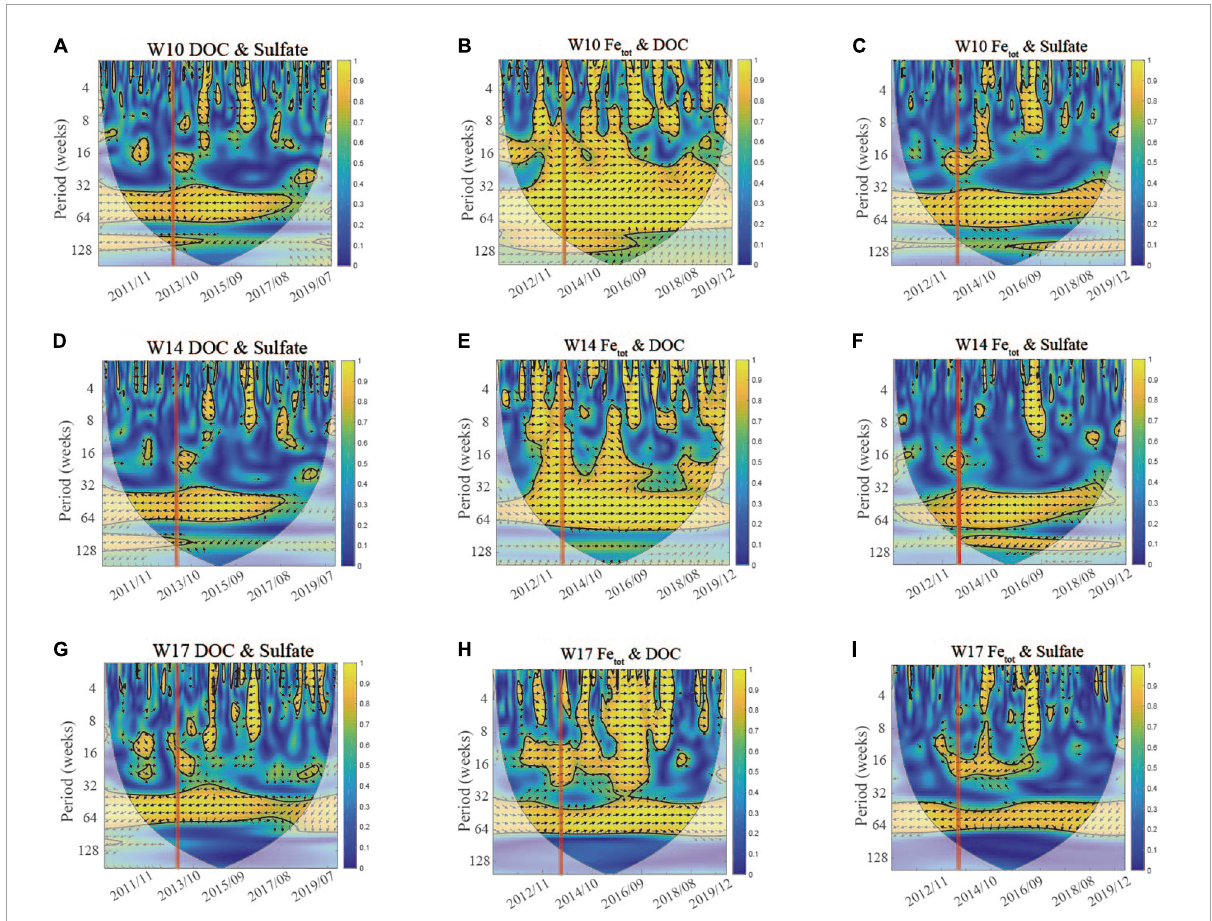
FIGURE7 The WTC analysis between dissolved organic carbon (DOC), total dissolved iron (Fe tot ) and sulfate at the 3 Wüstebach catchment stations (W10, W14, W17). The X -axis indicates the time and the y -axis displays the periods (in weeks). The cone of influence (COI) is shown as a cone-shaped area with thick black line (95% confidence level based on Monte Carlo test). The different colors indicate the strength of the correlation ( R 2 ) from 0 to 1. The black arrows indicate the orientation of the correlation with R 2 > 0.5 and the phase shifts between two variables (right directed: in-phase, positive, left directed: anti-phase, negative). The vertical red line indicates that the moment deforestation occurred in late summer